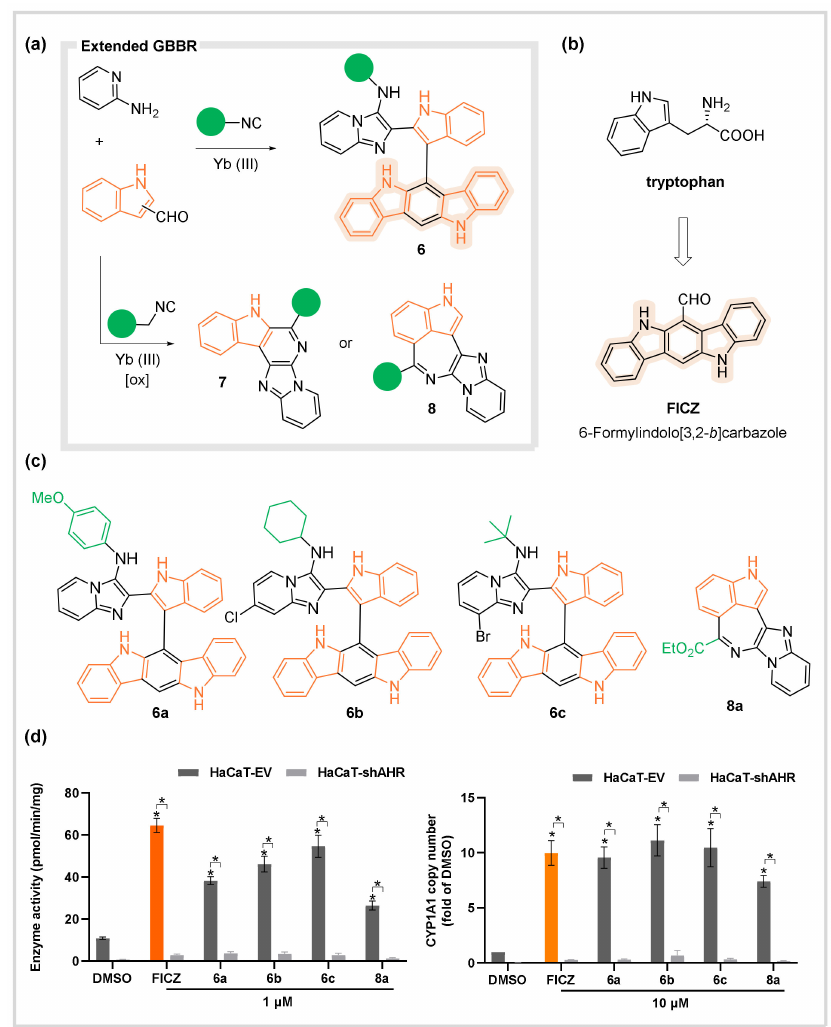
Figure 4. AhR Activators. ( a ) The extended GBBRs with indole carboxaldehydes. ( b ) FICZ ligand structure. ( c ) Novel MCR-based indolocarbazole ligands. ( d ) The AhR-activating properties of the synthesized compounds in keratinocytes (related to cytochrome P450 activity and expression). * p ≤